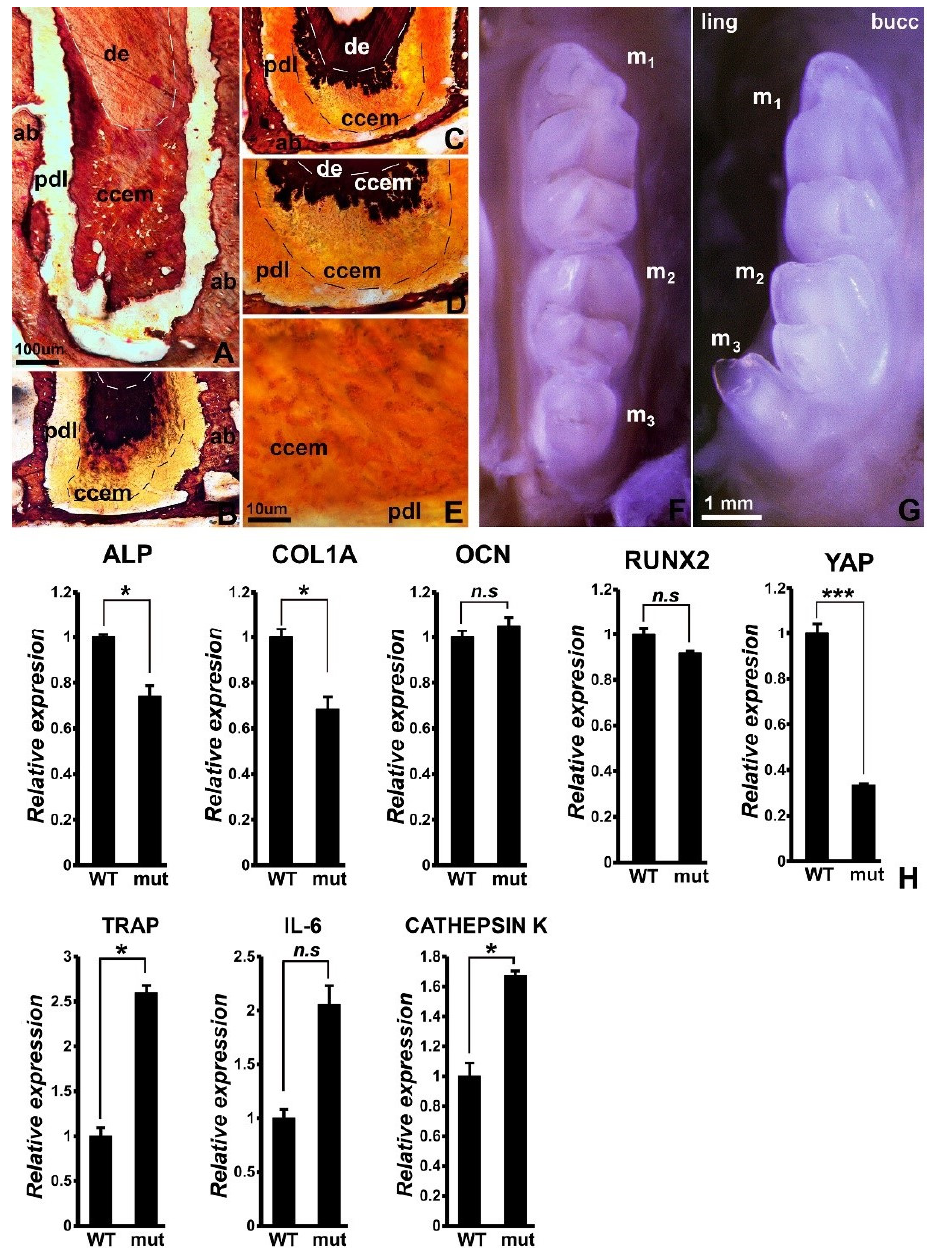
Figure 1. Effect of loss of YAP/TAZ on periodontal homeostasis. ( A – E ) Ultrathin ground sections stained with van Kossa’s stain as a mineralization marker. ( A ) is a control and ( B – E ) are from mutant mice at increasing levels of magnification. Alveolar bone (ab), root dentin (de), periodontal ligament (pdl), and cellular cementum (ccem) are labeled for orientation purposes. Note the partially mineralized cellular cementum (ccem) in the mutant mice. ( E ) illustrates incomplete mineralization of cellular cementocytes (ccem). ( F , G ) Mandibular tooth row comparison between wild type ( F ) and mutant ( G ) mice. The three mandibular molars (m1, m2, m3) are labeled. Note the lingual inclination of the third molar (m3) in YAP1/TAZ mutant mice ( G ). ( H ) Gene expression comparison for select mineralization related markers between wild type and Hippo mutant mice. Representative RT-qPCR for ALP, COL1A, OCN, RUNX2, YAP1, TRAP, IL-6, and cathepsin K transcript levels in mandibles from wild type and Hippo mutants. Transcript levels were normalized to β -actin levels and are presented as fold difference. As expected, YAP1 levels are down 70% in Hippo mutant samples. Representative data from n > 3. t test for statistical level of significance; *, p < 0.05; ***, p < 0.005, n.s , not significant. The bar in ( A ) is for ( A – D ). ( E ) is at a 10 × higher